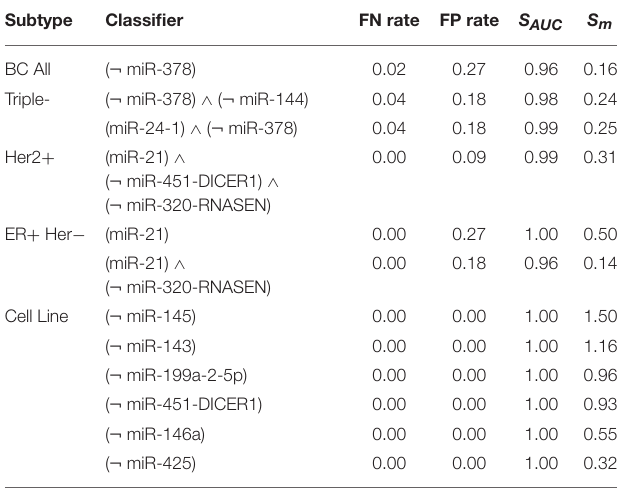
TABLE 2 | Evaluation of breast cancer classifiers with scores: false negative rate, false positive rate, AUC, average margin and worst